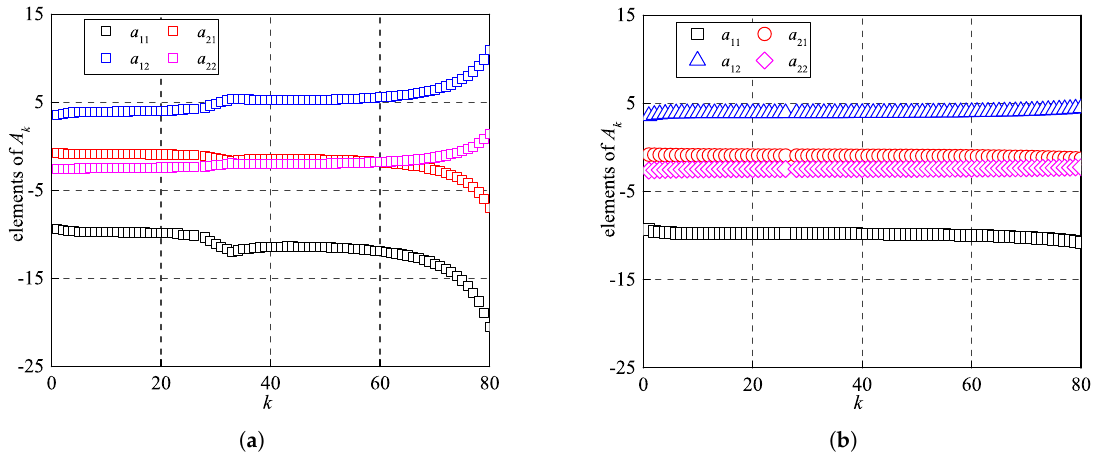
Figure 5. Distribution of the elements of A k . ( a ) r ub = 10 − 4 . ( b ) r ub = 10 − 8